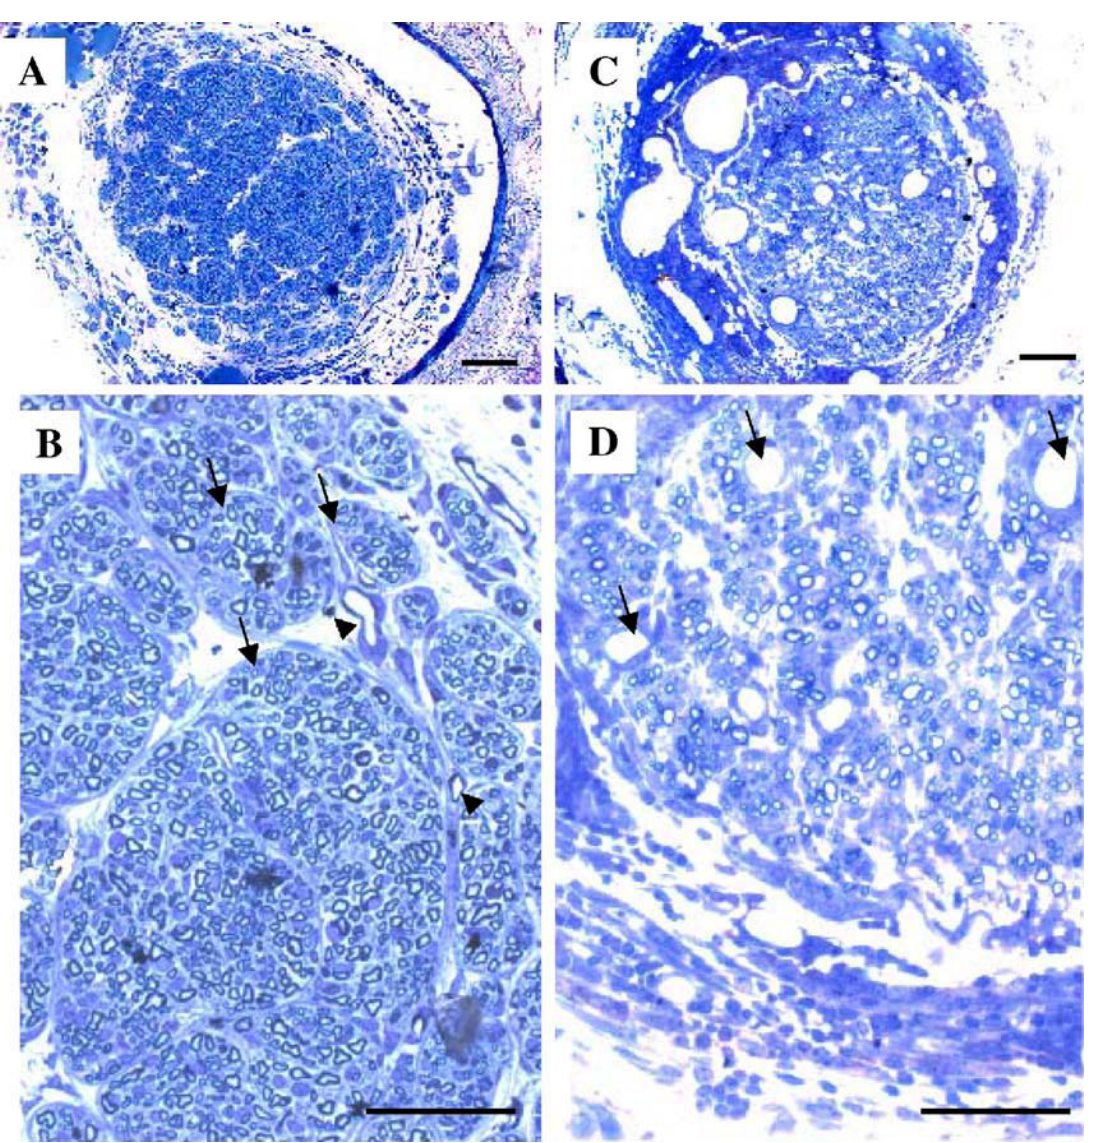
Figure 6. Semi-thin cross-sections of regenerated nerve tissues 6 weeks after injury. A and B : bone marrow-derived cell (BMDC)-seeded group; C and D : control group. Scale bar: 40 µm. Reprinted from [212] with permission from